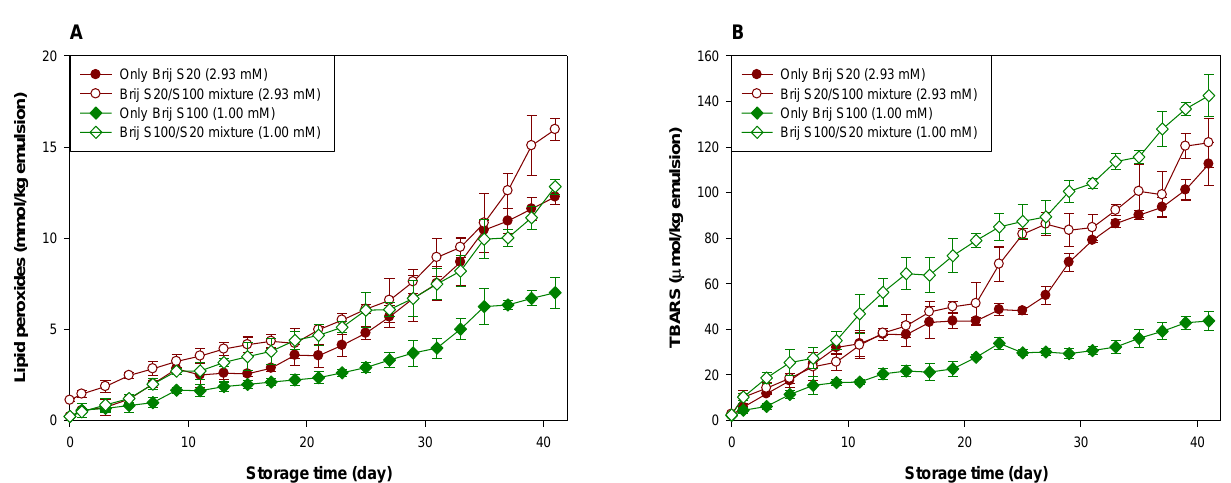
Figure 2. Evaluation of lipid peroxides ( A ) and TBARSs ( B ) in emulsions stabilized with the mixture of Brij S20 and S100 (5:5) at a surfactant concentration of 2.93 and 1.00 mM at pH 3. Table 1. Production rate constant ( k (mmol/kg emulsion/day)) of lipid peroxides of emulsions stabilized with Brij surfactant mixtures at a surfactant concentration of 2.93 and 1.00 mM at pH 3. Surfactant Concentration: 2.93